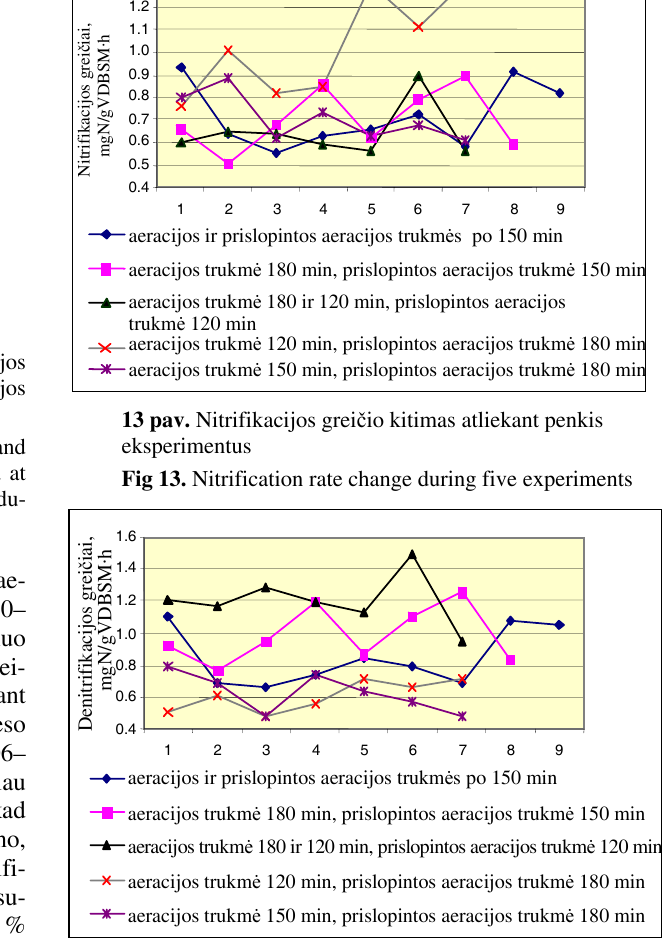
14 pav. Denitrifikacijos grei č io kitimas atliekant penkis Fig 14. Denitrification rate change during five